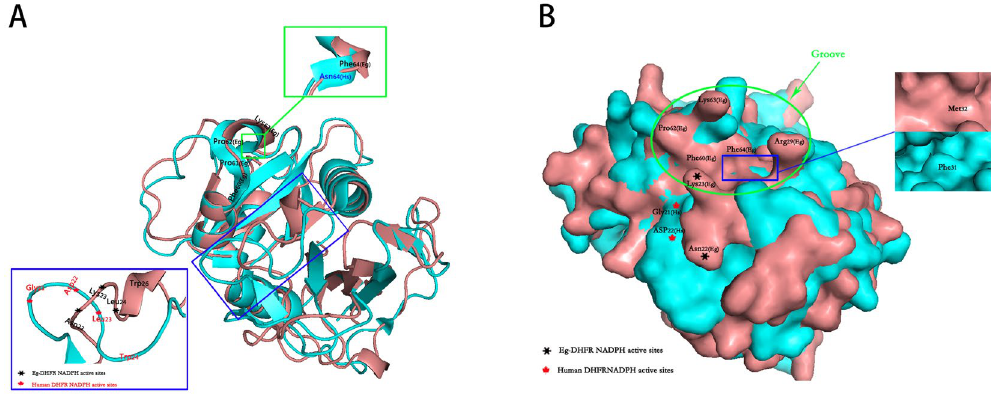
Figure 2. Comparison of the three-dimensional structure of DHFR between E. granulosus and Homo sapiens . The 3D structure of Eg-DHFR was modelled based on the crystal structure of Schistosoma mansoni DHFR (PDB accession code: 3vco.1). The global and per-residue model quality of Eg-DHFR has been assessed using the QMEAN scoring function (GMQE and QMEAN value were 0.76 and − 0.14, respectively). 3D structure of Eg-DHFR (deepsalmon) was aligned to DHFR of H. sapiens (cyan; PDB accession code: 3gyf.1), and shown as cartoon ( A ) and surface ( B ). Important structural difference were enlarged.